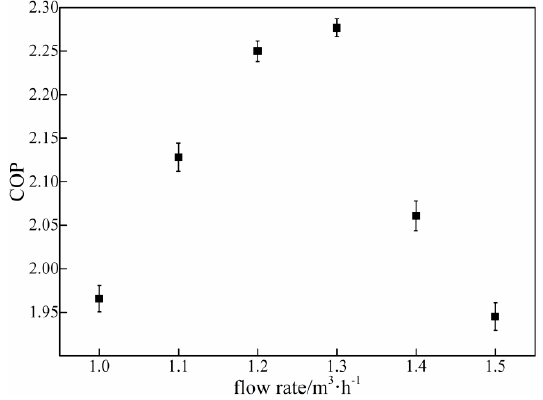
Figure 11. Effects of flow rates on COP.